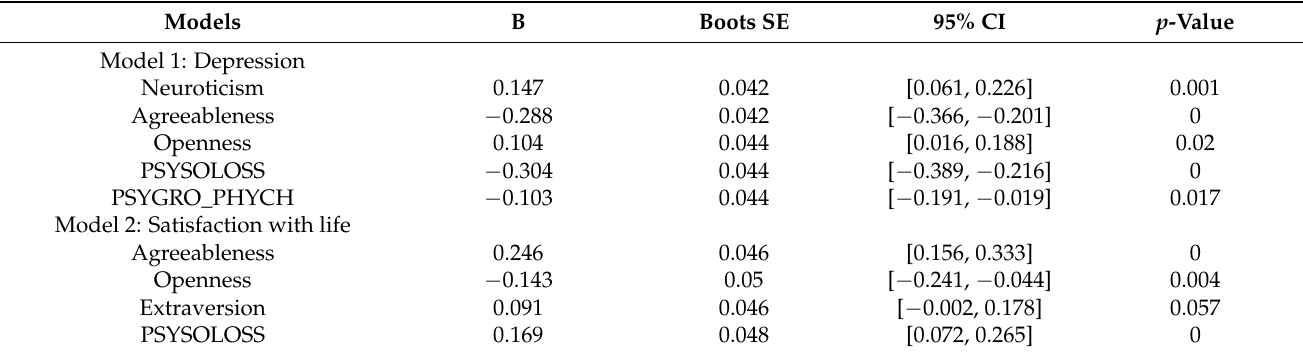
Table 5. Total effects of the models on mental health (depression and life